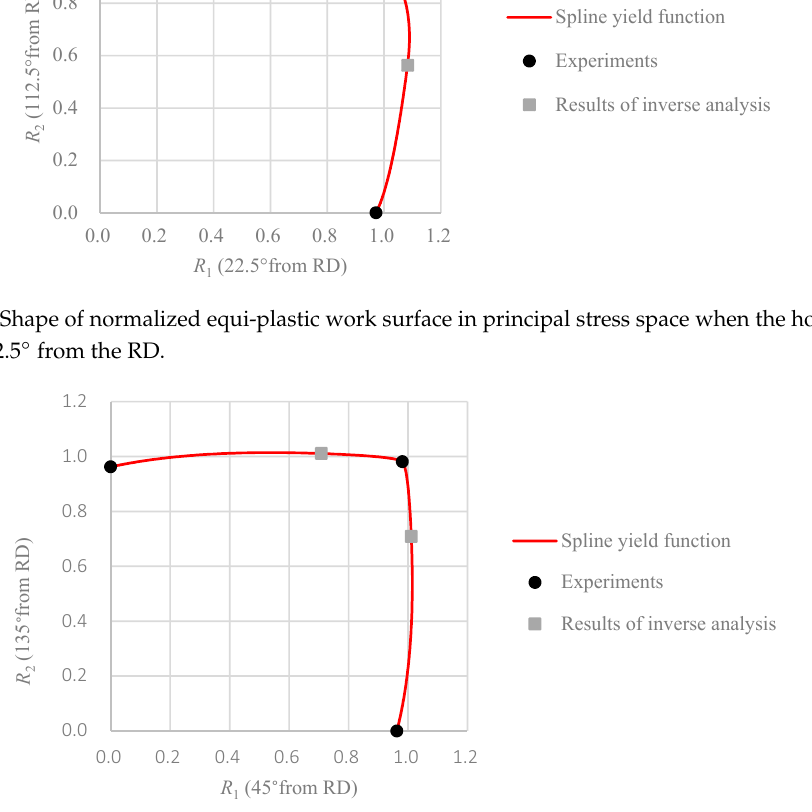
Figure 14. Shape of normalized equi-plastic work surface in principal stress space when the horizontal axis was 45° from the RD.